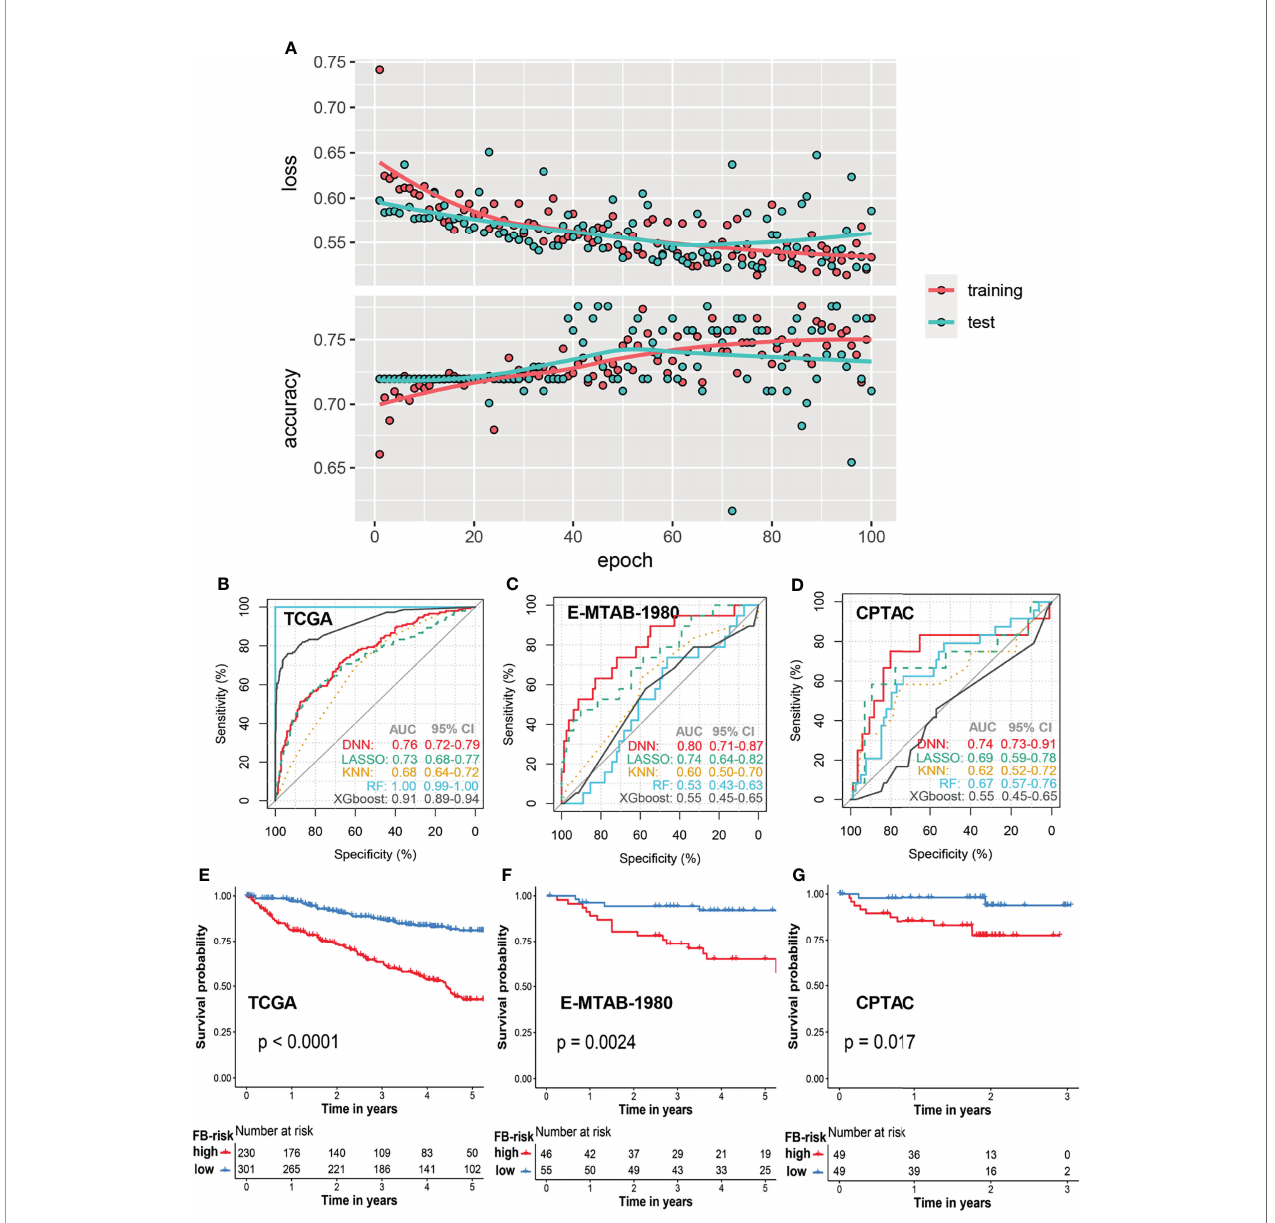
FIGURE 2 | Prognosis model based on the f-box family using deep learning for ccRCC. (A) The learning curves of the deep learning model in the training cohort and test cohort. (B – D) Comparison of prognosis prediction in the 5-year follow-up using LASSO, KNN, XGBoost, RF, and deep learning methods in the TCGA cohort, E-MTAB-1980 cohort, and CPTAC cohort, respectively. (E – G) Kaplan – Meier survival analysis of overall survival strati fi ed by FB-risk for ccRCC in the TCGA cohort, E-MTAB-1980 cohort, and CPTAC cohort, respectively. ccRCC, clear cell renal cell carcinoma; TCGA, The Cancer Genome Atlas; CPTAC, Clinical Proteomic Tumor Analysis Consortium; LASSO, Least Absolute Shrinkage and Selection Operator; KNN, k-nearest neighbor; RF, random forest; FB-risk, f-box family-related